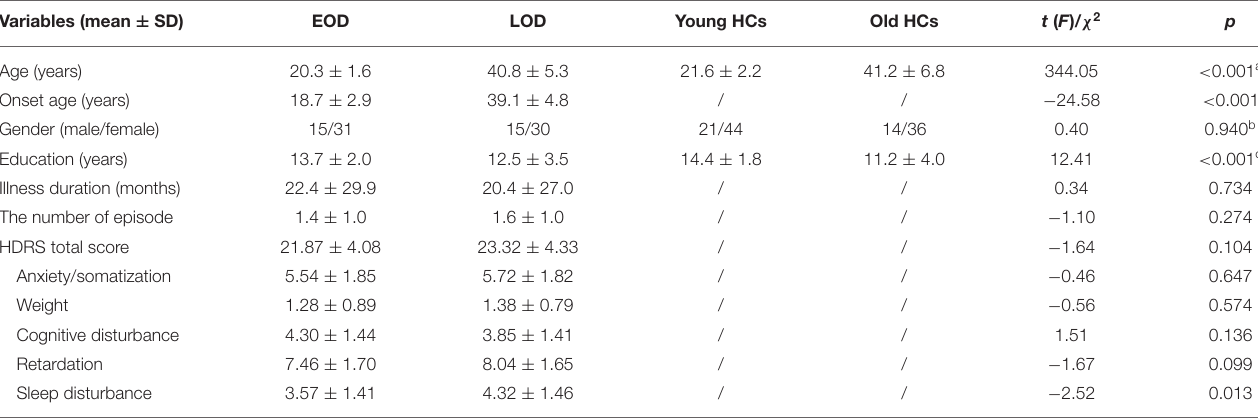
TABLE 1 | The demographics and clinical characteristics of the MDD and HCs